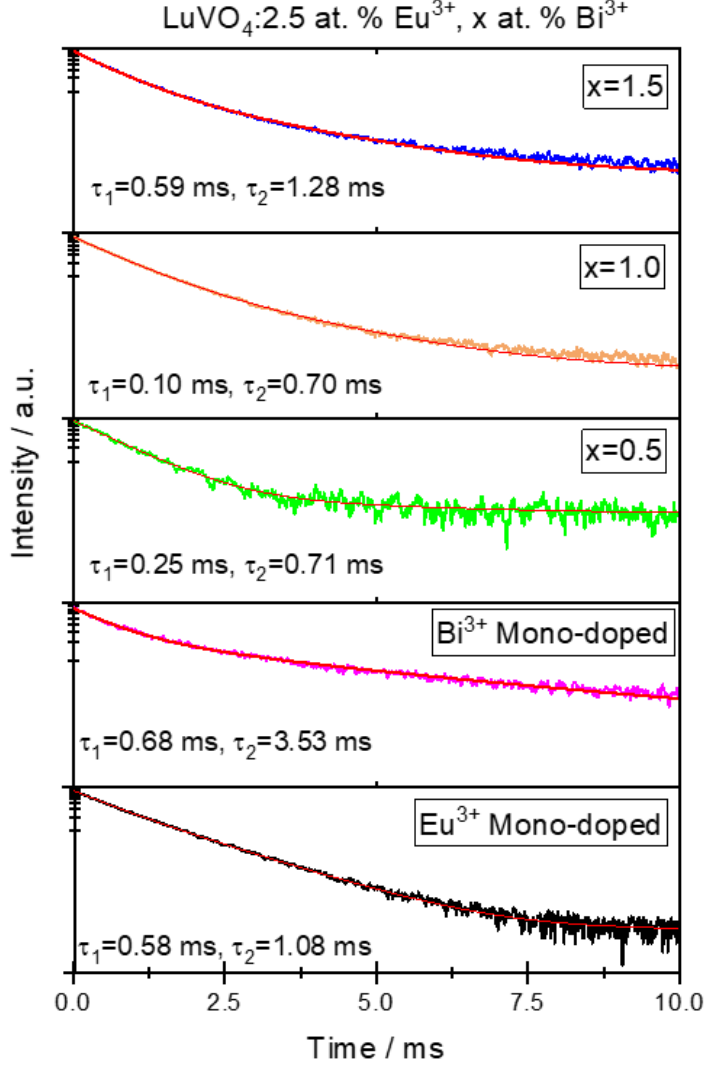
Figure 11. Decay curves of LuVO 4 :Eu 3+ , Bi 3+ films. On the other hand, the quality of the light emission is evaluated by the CIE 1931 color matching function, the correlated color temperature (CCT), and the color purity (CP), to understand the fluoresce center [66–69]. Table 2 presents the CIE color coordinates for different concentrations of bismuth; the mono-doped Bi film presents coordinates (0.3611, 0.5124) that are congruent with the results of Krishnan (2018), which studied bismuth silicate glasses for white light generation and bismuth silicate oxyfluoride glasses for LED applications. The calculated CCT values are below 3000 K in the co-doped films and, therefore, could be useful for warm light sources. When Bi is incorporated with 2.5 at. % Eu, the CP improved to 0.86. This highest CP and low CCT with the CIE coordinates moving to the red emission region is due to the energy transfer, as explained earlier, which is congruent with similar reports